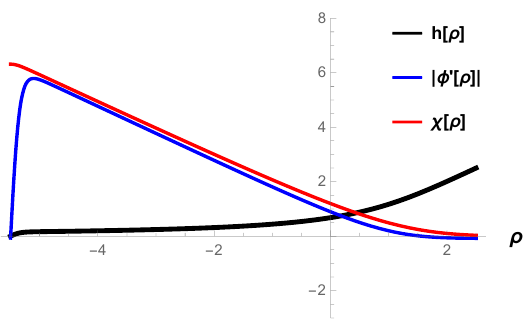
Figure 3 . Solutions of h ( ρ ) , − Φ 0 ( ρ ) and χ ( ρ ) , for the A < A c solution shown in figure